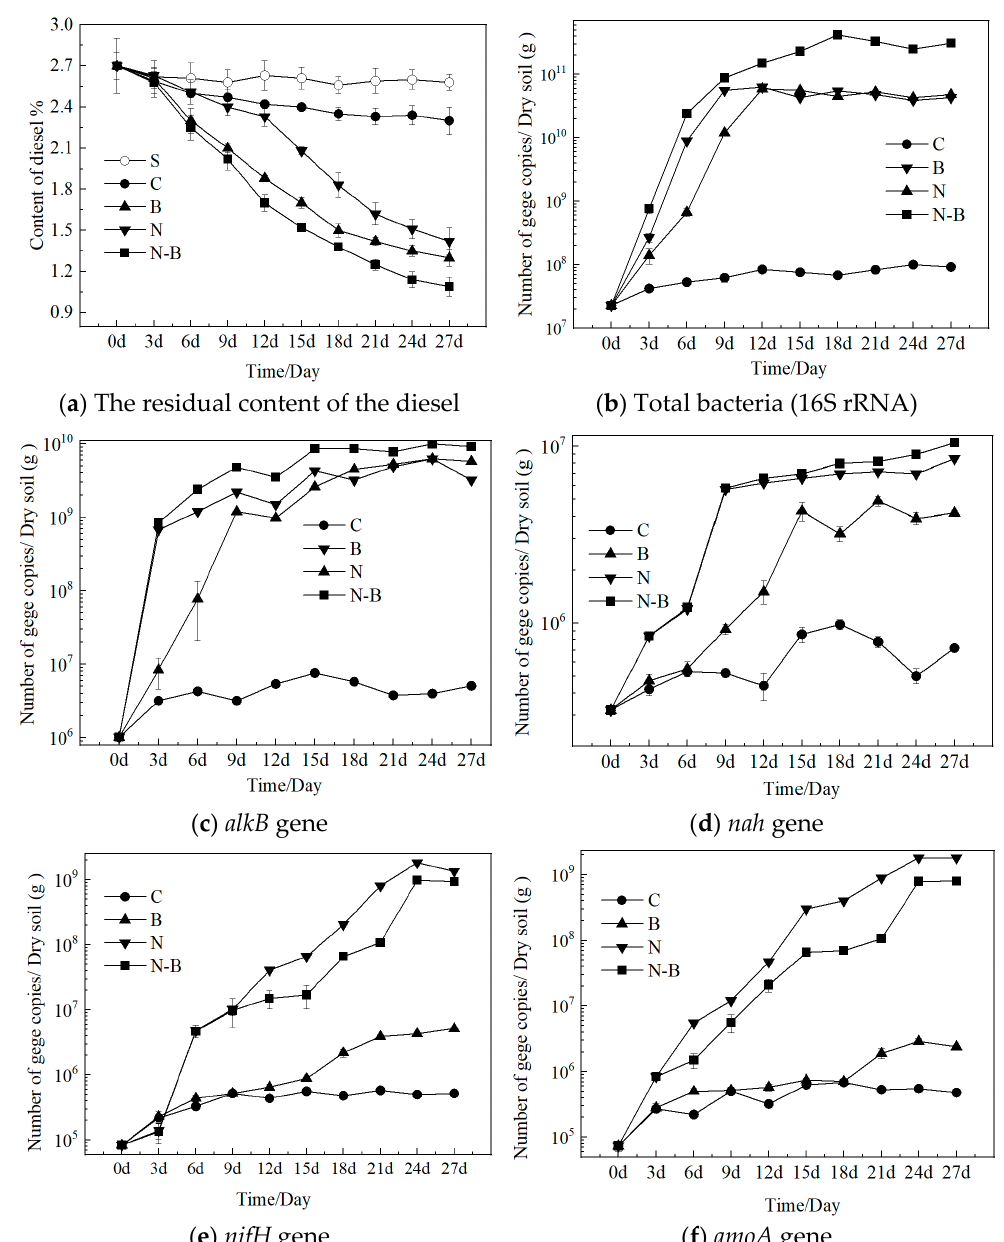
Figure 2. The changes of diesel contents and functional genes during different bioremediation processes.